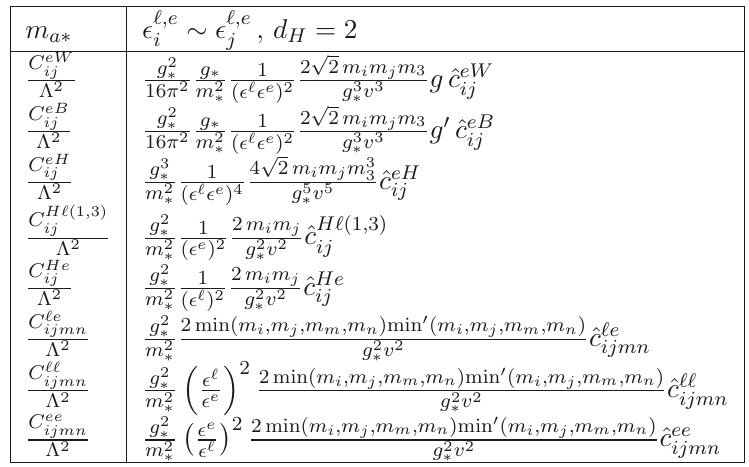
Table 8 . Here we present the Wilson coefficients of the dim-6 operators in the mass basis, assuming the strong dynamics gives rise to flavor dependent dynamical scales m a ∗ . The results shown are for ǫ ℓ,e ǫ ℓ,e i ∼